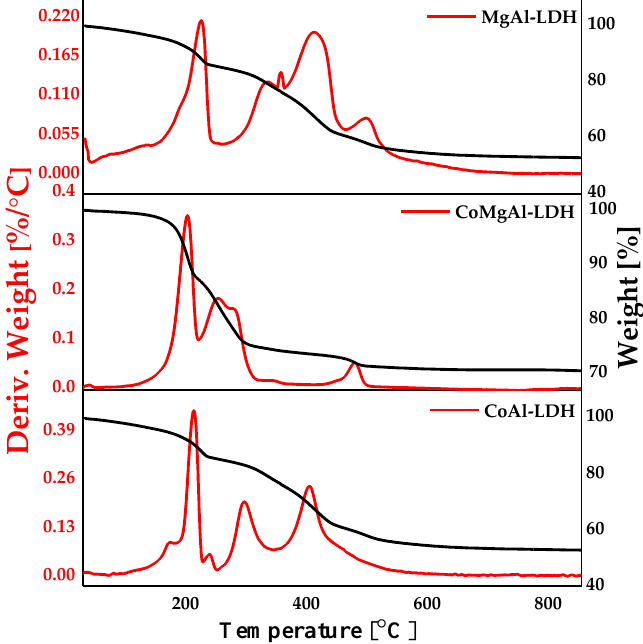
Figure 2. Thermal gravimetric and differential thermal gravimetric analyses of all catalysts.